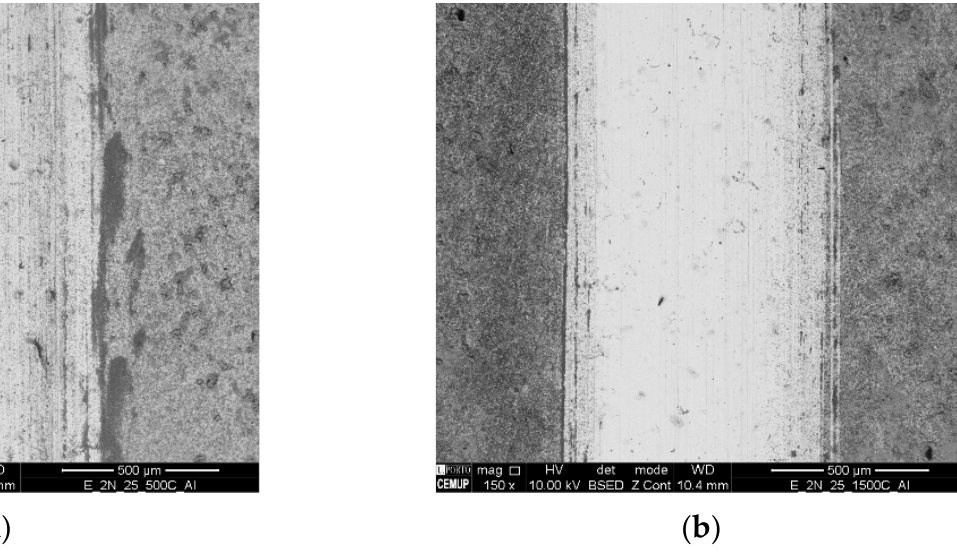
Figure 12. SEM track analysis for abrasive alumina powder, ( a ) SC-25 g/100 mL, 500 cycles; ( b ) SC-25 g/100 mL, 1500 cycles.